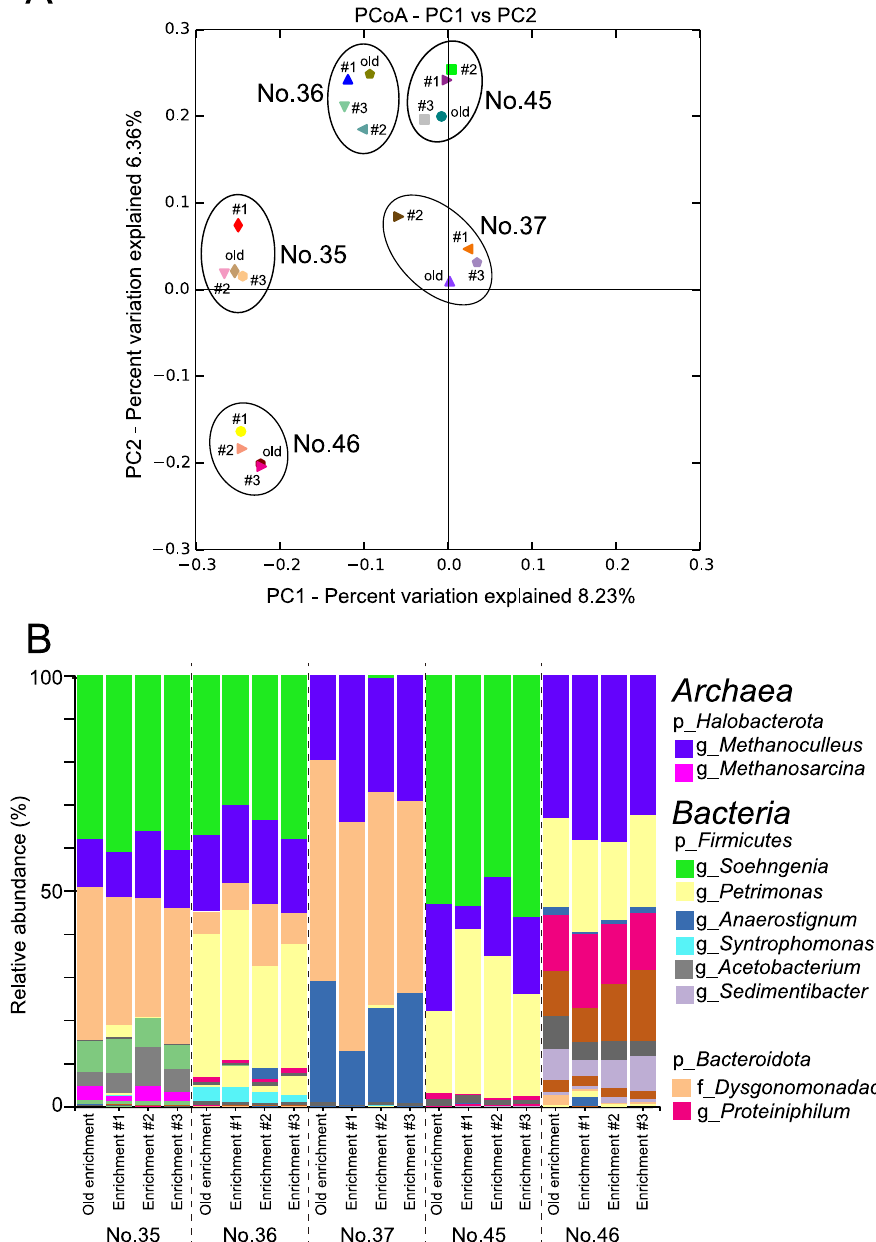
Figure 1. Microbial community structure of the five kinds of methanogenic enrichment cultures (MECs). ( A ) Principal coordinates analysis (PCoA) of the “Old” and the last 3 passages of each enrichment culture (#1, 2, and 3); ( B ) Phylogenetic distribution of each MEC based on the 16S rRNA gene analysis. Major taxonomic groups with a relative abundance of >c.a. 1.0% were indicated. p—Phylum level; f—Family level; g—Genus